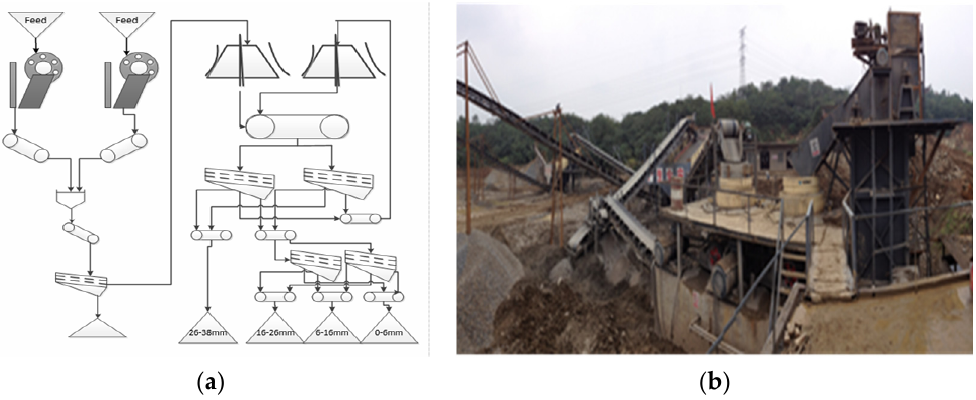
Figure 2. ( a ) Typical flow sheet of crushing plant; ( b ) Typical flow sheet of two-stage aggregates production plant in